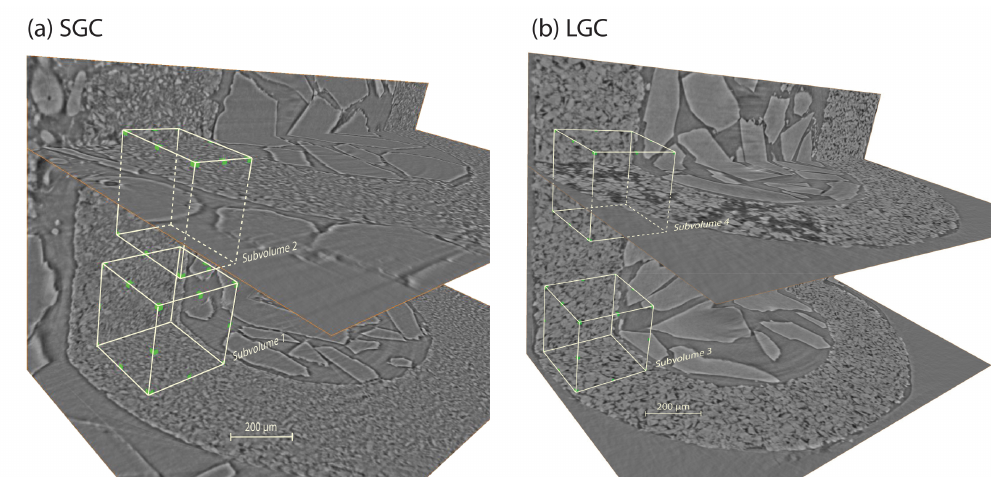
Figure 4. Positions of the subvolumes in the cup wall of (a) SGC and (b) LGC, where quantitative 3-D microstructure analyses were performed. In the SGC sample, subvolume 1 (bottom box) is located at the center of the cup wall. Subvolume 2 (top box) is located adjacent to the outer rim of the wall. In the LGC sample, both subvolume 3 (bottom box) and subvolume 4 (top box) are located at the center of the cup